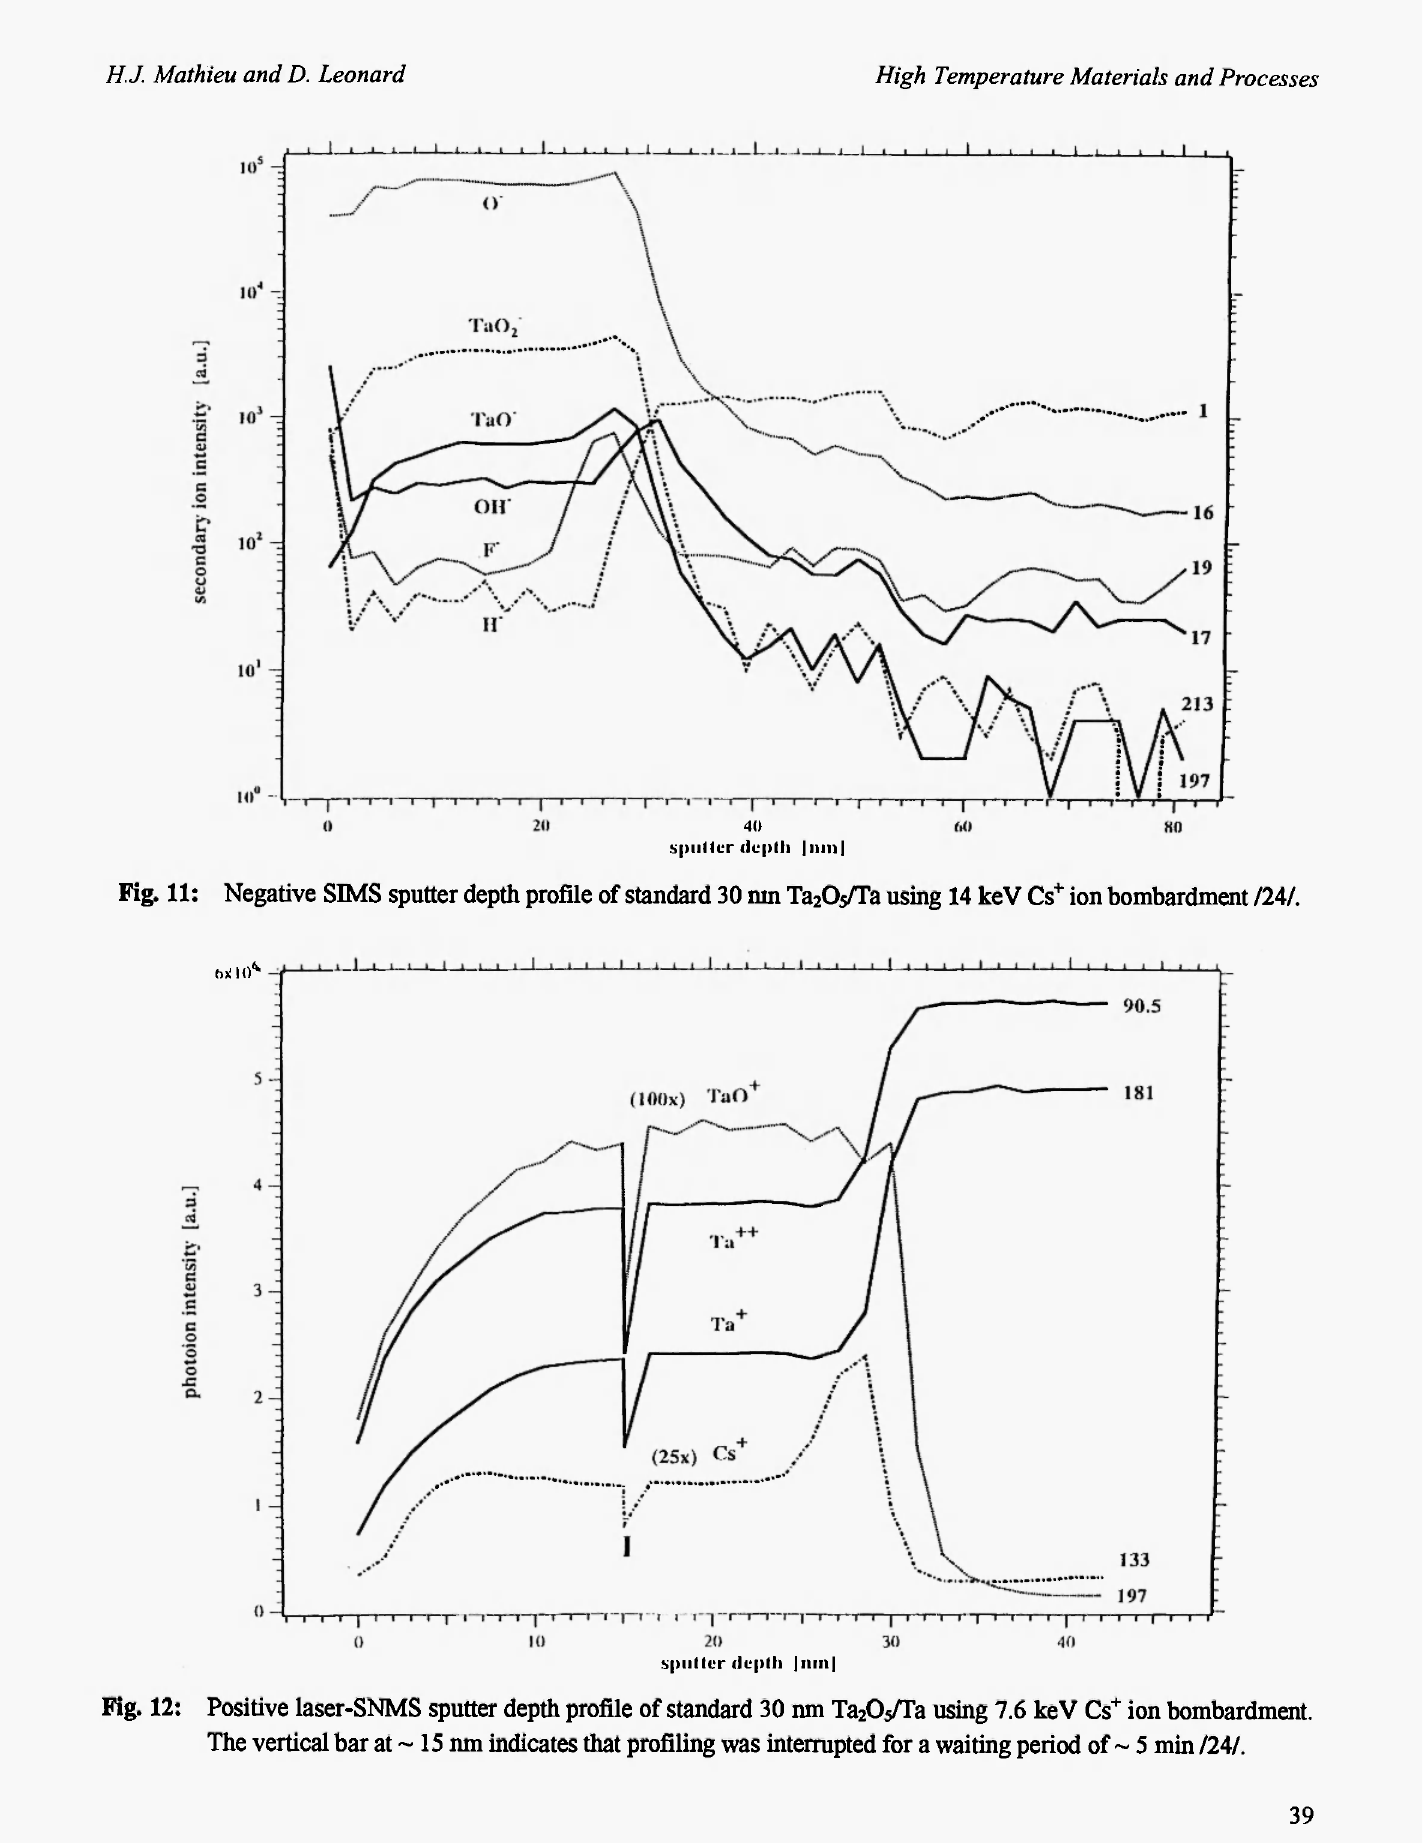
05/Ta using 14 keV Cs + ion bombardment /24/. 2